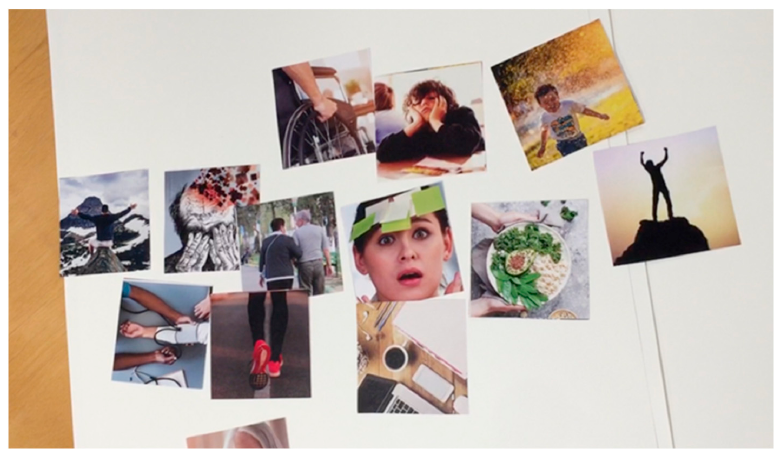
Int. J. Environ. Res. Public Health 2022 , 19 , x FOR PEER REVIEW Figure 3. Example of the complication cards presented to the Age Workshop participants.